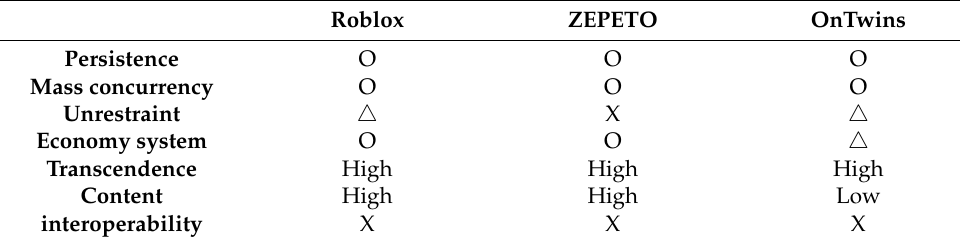
Figure 17. Past Sinuiju and Cheorwon. Table 4. Compare Metaverse Platforms based on Seven Necessary